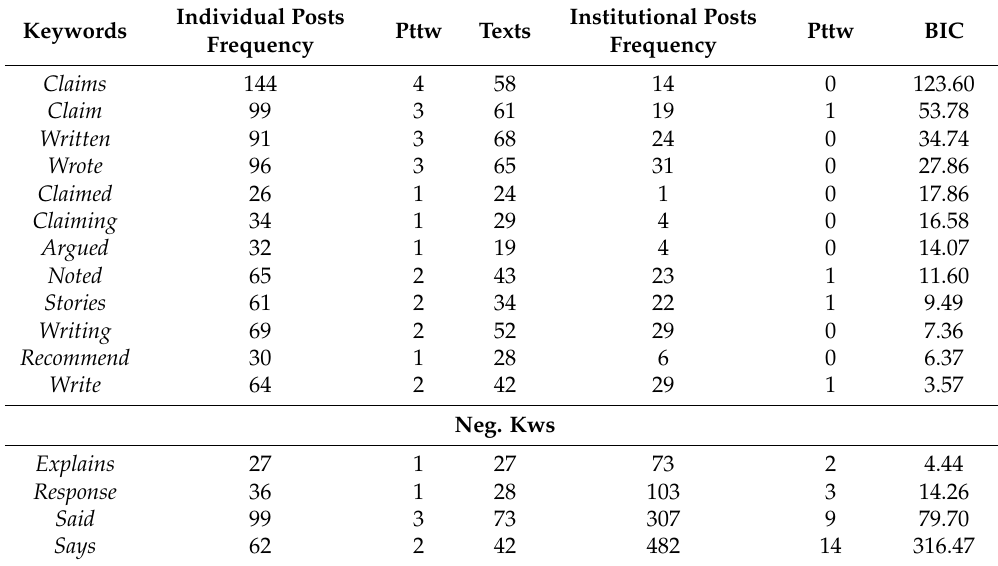
Table 4. Attribution and the representation of discourse in individual blogs.